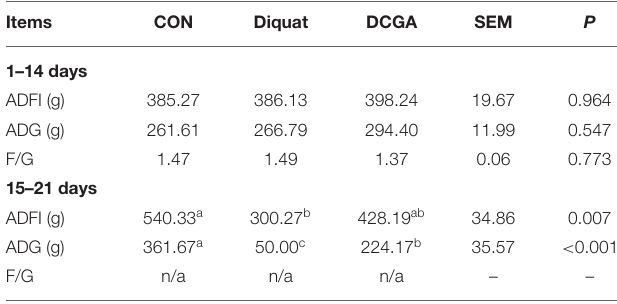
TABLE 1 | Effects of CGA on the growth performance in weaned pigs upon oxidative stress 1 .